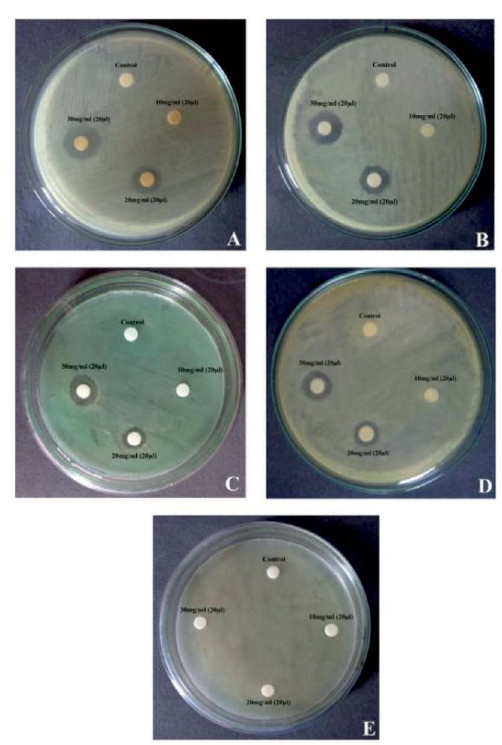
Fig. 1. Antibacterial activity of ethanolic rhizome extract of Coleus forskohlii on bacterial pathogens A: Bacillus subtilis ; B: Bacillus cereus ; C: Pseudomonas aeruginosa ;